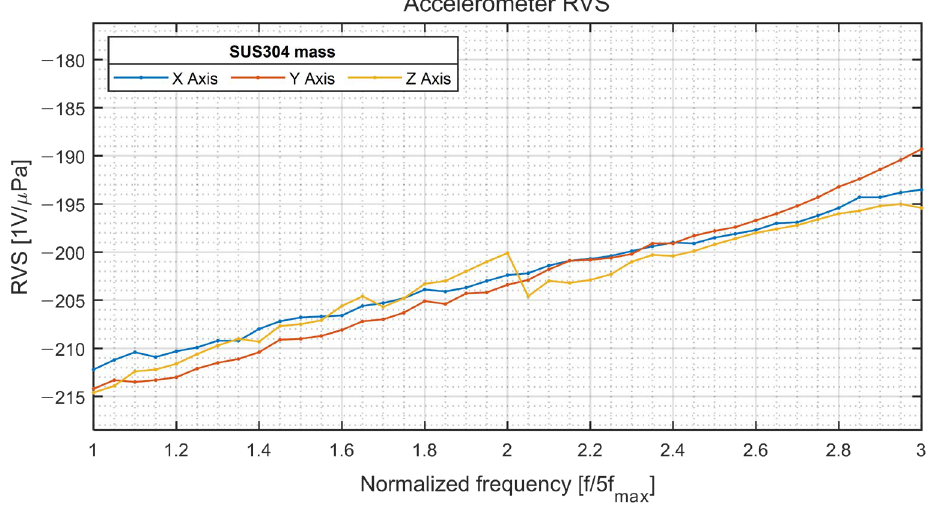
Figure 13. Underwater receptor voltage sensitivity of the accelerometer. At a normalized frequency of approximately 3.25 (Figure 11), a sharp drop of − 10 dB in sensitivity was observed, possibly caused by a feature of the contact